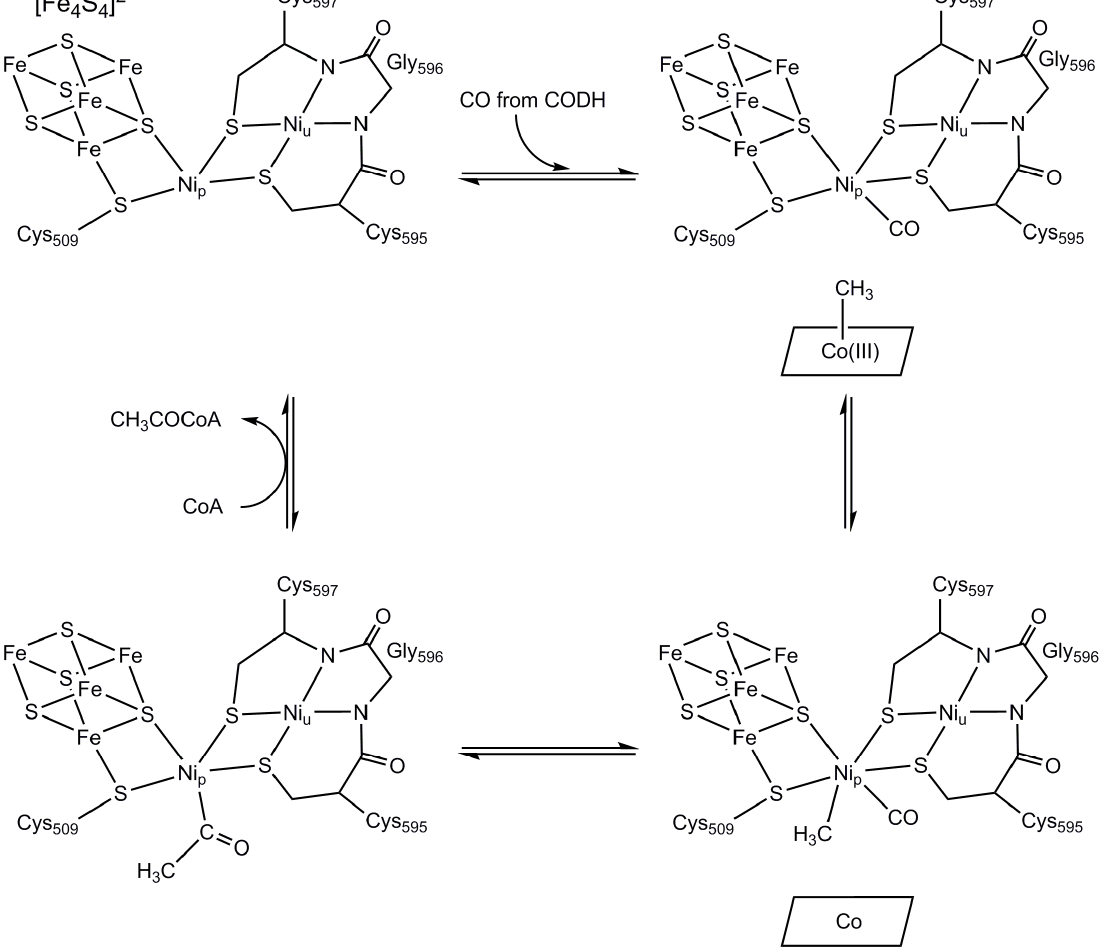
Figure 9. Mechanism of Acetyl CoA suggested on the basis of quantum mechanics (QM) cluster calculations. Adapted from [98], Copyright © 2005, American Chemical Society.